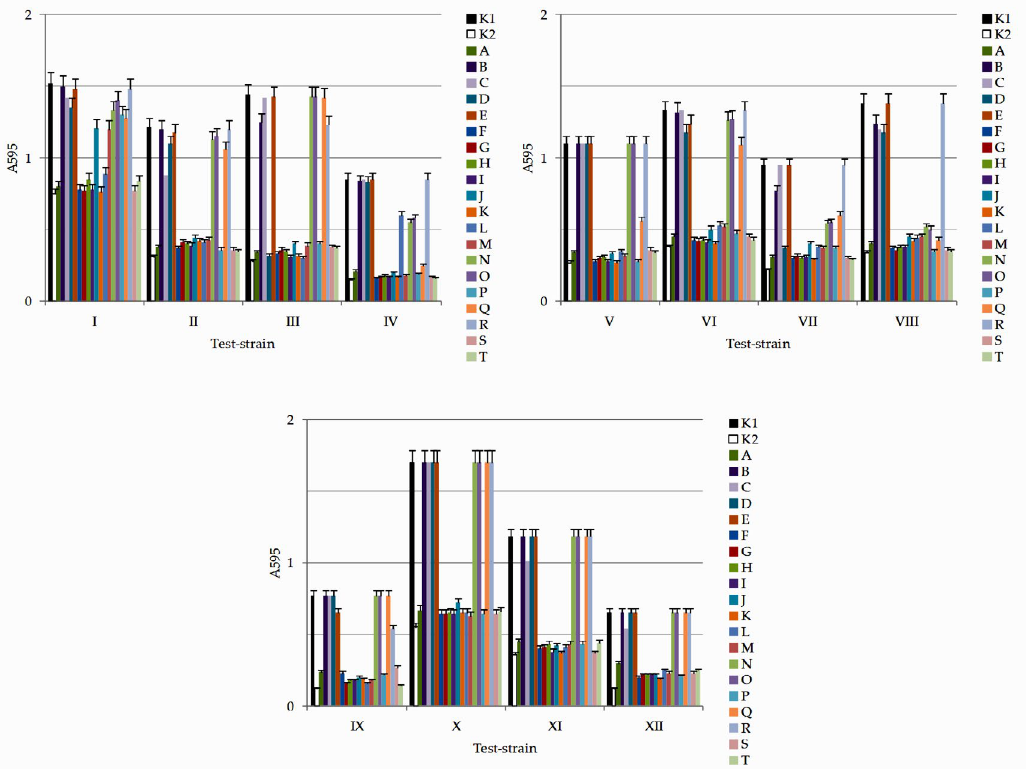
Fig. 2. Results of determination of antimicrobial activity against test-cultures I – E. coli ; II – S. enterica ; III –